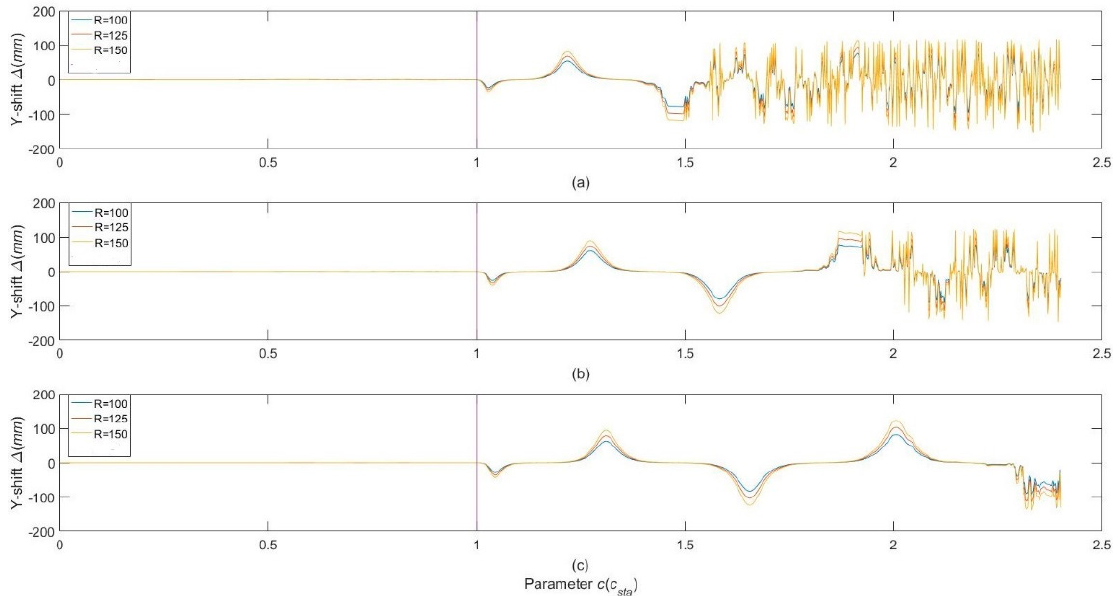
Figure 5. Dependency of Δ upon the parameter c with different parameter sets of: ( a ) p = 98, q = 47; ( b ) p = 150, q = 73; ( c ) p = 198, q = 97, where Δ is the Y-shift of chief ray exit point, c is the distance between the center of curvature and the plane that the reflection spots lie on, and c sta is the upper limit of c that calculated by Equation (38). Curves with different colors indicate different radii of curvature, while the black line indicates the boundary divided by c sta . One can see that when c ≤ c sta , the Y-shift of exit point is close to zero and varies weakly as c increases. When c > c sta , the Y-shift varies significantly and frequently as c increases. Therefore, c sta can be regarded as the upper limit of c in parametric